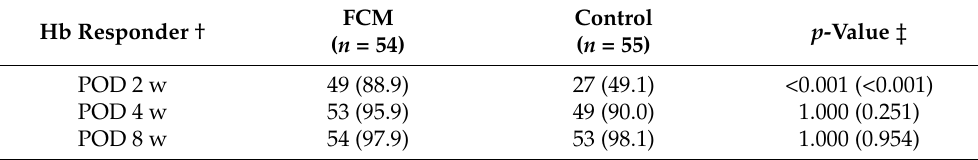
Table 2. Postoperative Hb